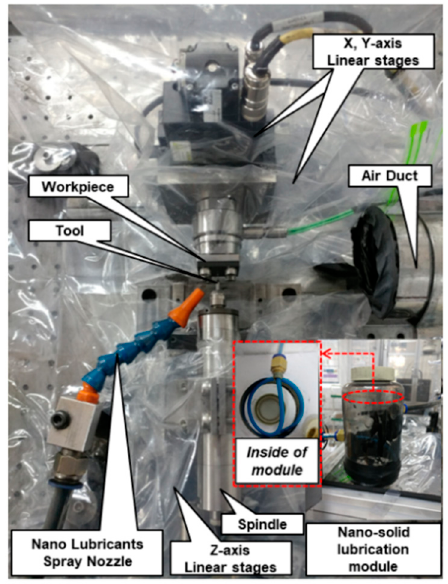
Figure 9. Experimental set-up for MD-CFRP machining using nano-solid dry lubrication